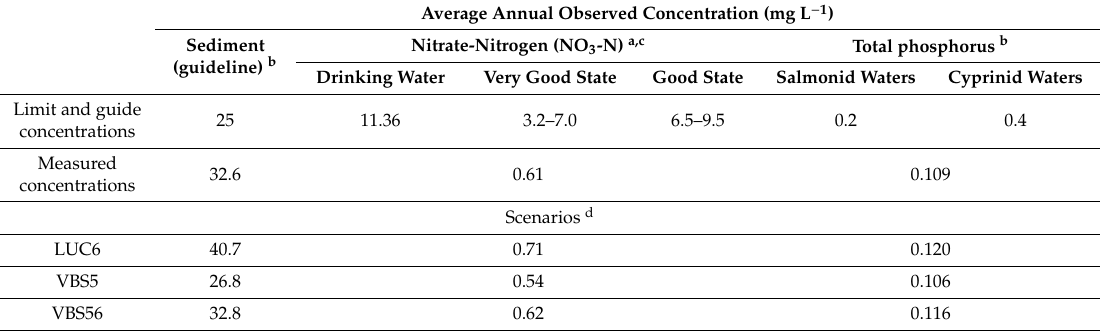
Table 11. Comparison of the e ff ects of land-use scenarios on the average annual concentration of sediment, nitrate nitrogen, and total phosphorus (mg L − 1 ) at the outflow of the river Kožbanjšˇcek—values were recalculated from the average daily loads using daily